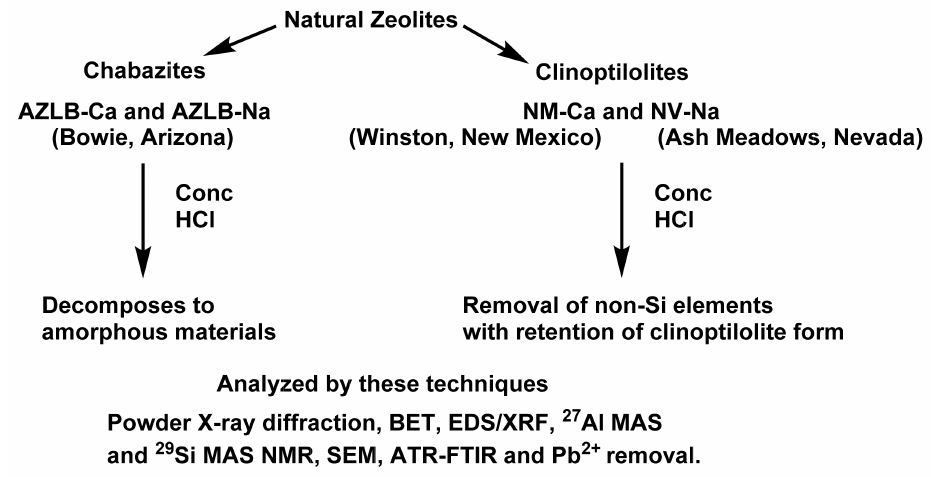
Scheme 1. Flow chart summarizing results and listing utilized analytical